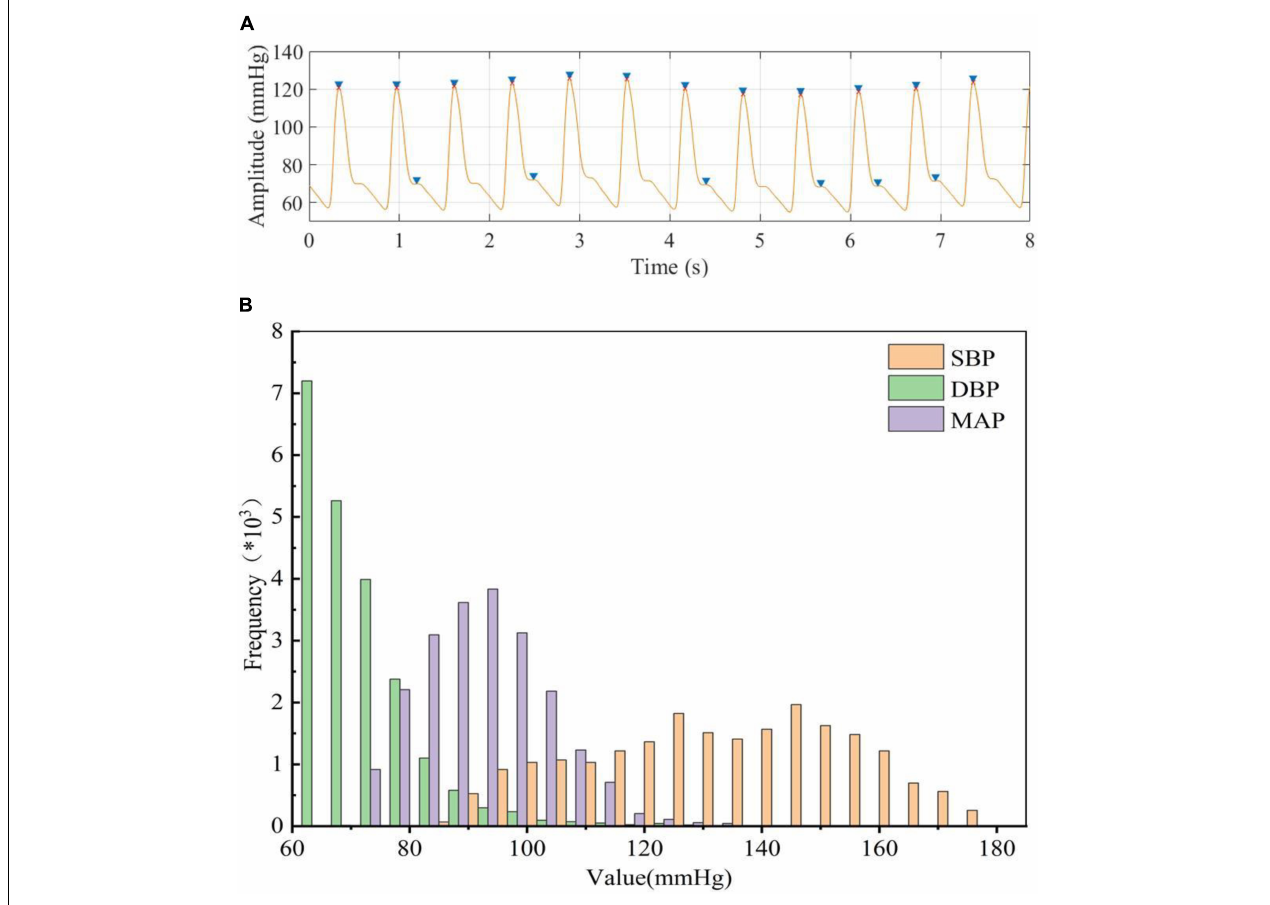
FIGURE 3 | (A) blue “ (cid:73) ” represents peak detection before processing, red “x” represents peak detection after processing, (B) Statistical histogram of BP data extracted from